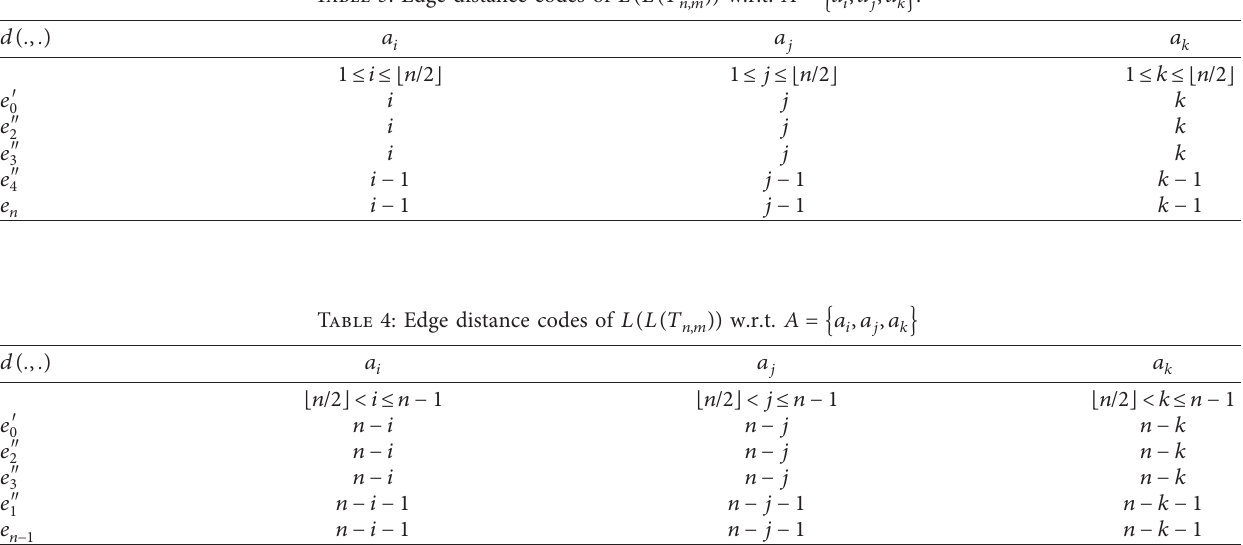
Table 3: Edge distance codes of L ( L ( T